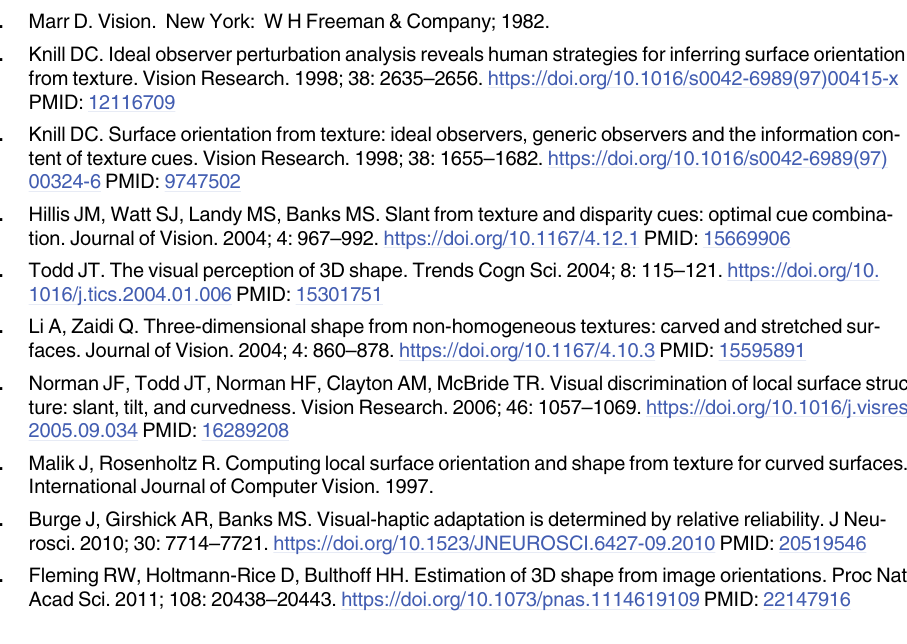
estimation error (blue), plotted as a function of groundtruth tilt. The left and right columns represent data from Exp 1 and Exp 2, respectively. F Best estimation diameters are correlated with the diameters fit to the natural scene statistics. G Equivalent pooling diameter fit to the natural scene statistics and equivalent pooling diameters that minimize prediction error, plot- ted as a function of groundtruth tilt. H Best prediction diameters are correlated with the diam- eters fit to the natural scene